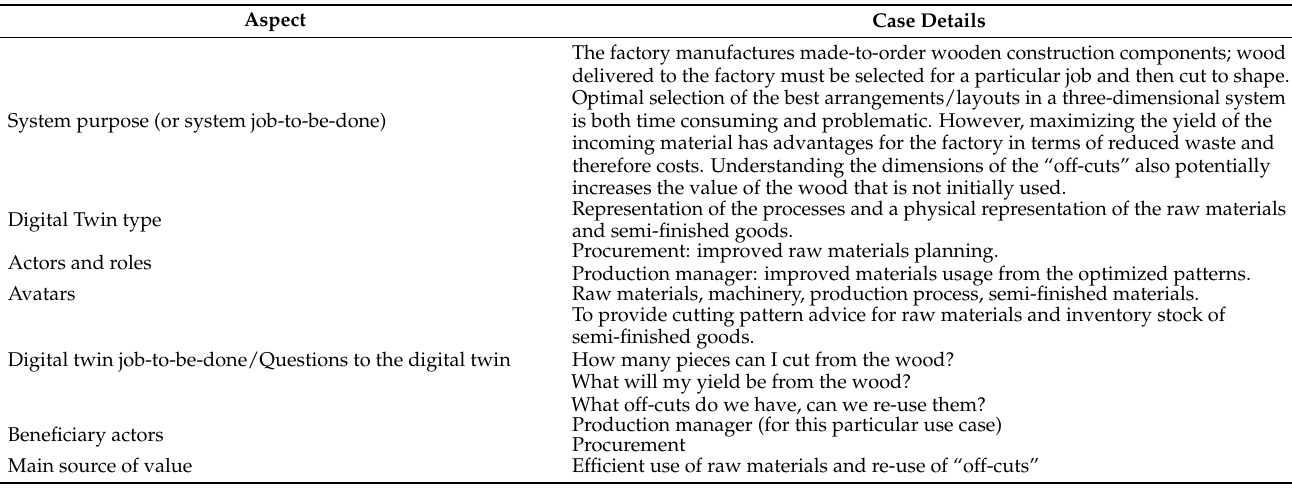
Table A5. Case 3—wood pattern cutting digital twin.